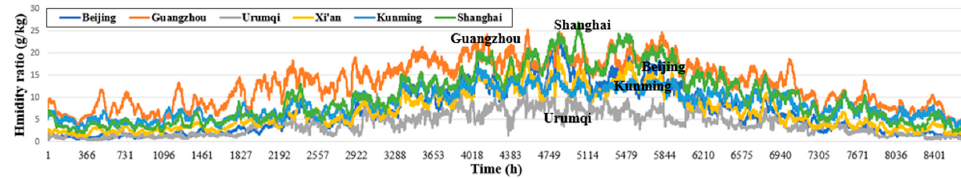
Figure 10. The comparison of humidity ratios of selected cities.